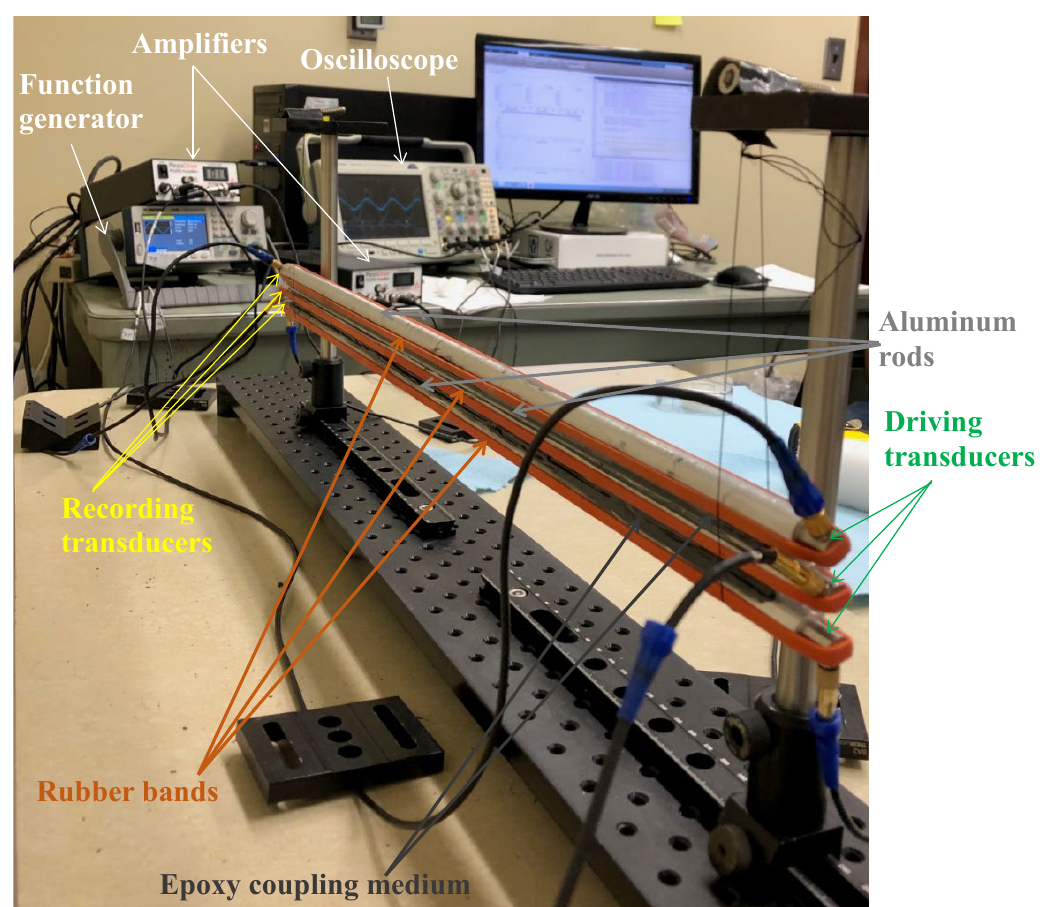
Figure 2. Experimental setup for the nearly free-standing array of coupled waveguides is suspended by threads to two supporting stands. To drive the coupled waveguides three transducers are used at one end, and to detect at the other end three more transducers are used. A constant pressure is maintained on the transducers with the use of rubber bands. Honey is used as coupling between the rods and the transducers.